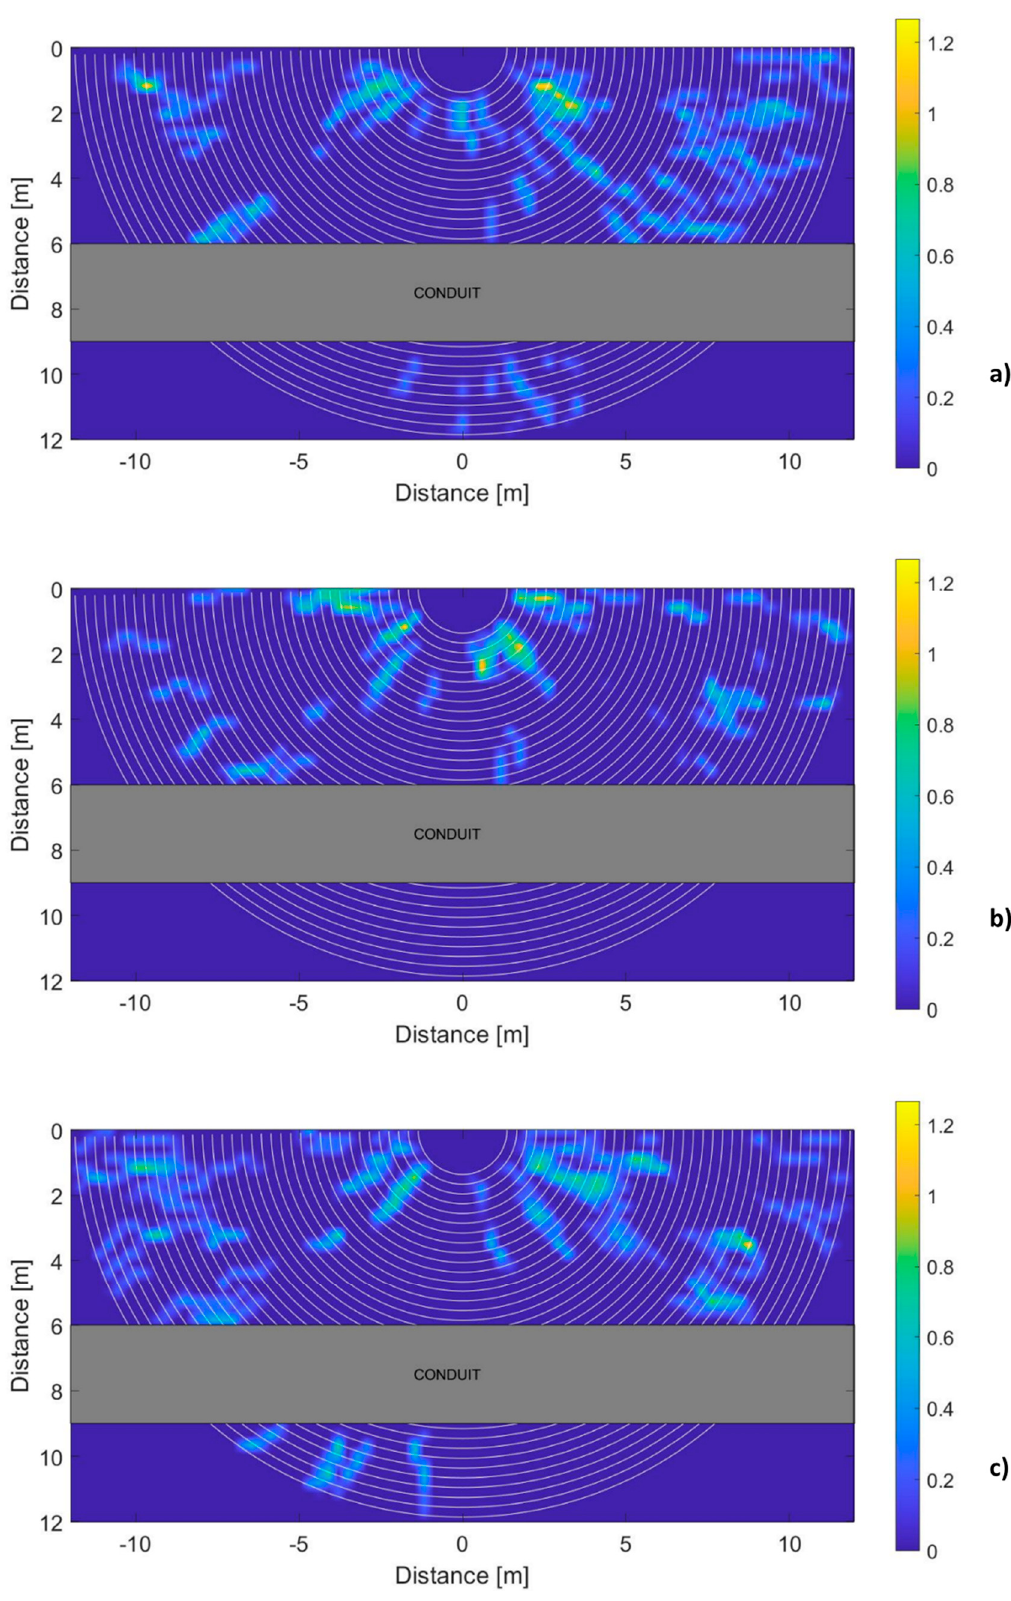
Figure 14. Root mass density maps at different depths: ( a ) from 0.30 m to 0.40 m, ( b ) from 0.40 m to 0.50 m, and ( c ) from 0.50 m to 0.60 m.